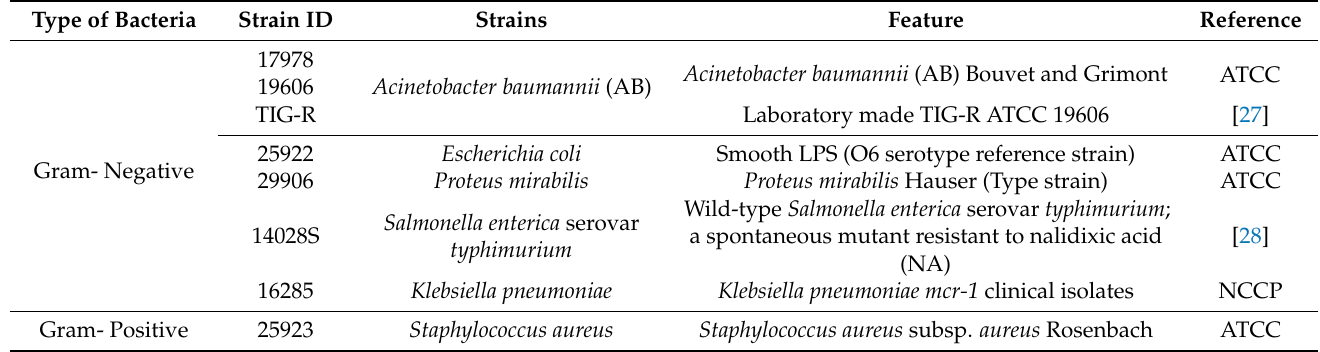
Table 1. Strains used in this